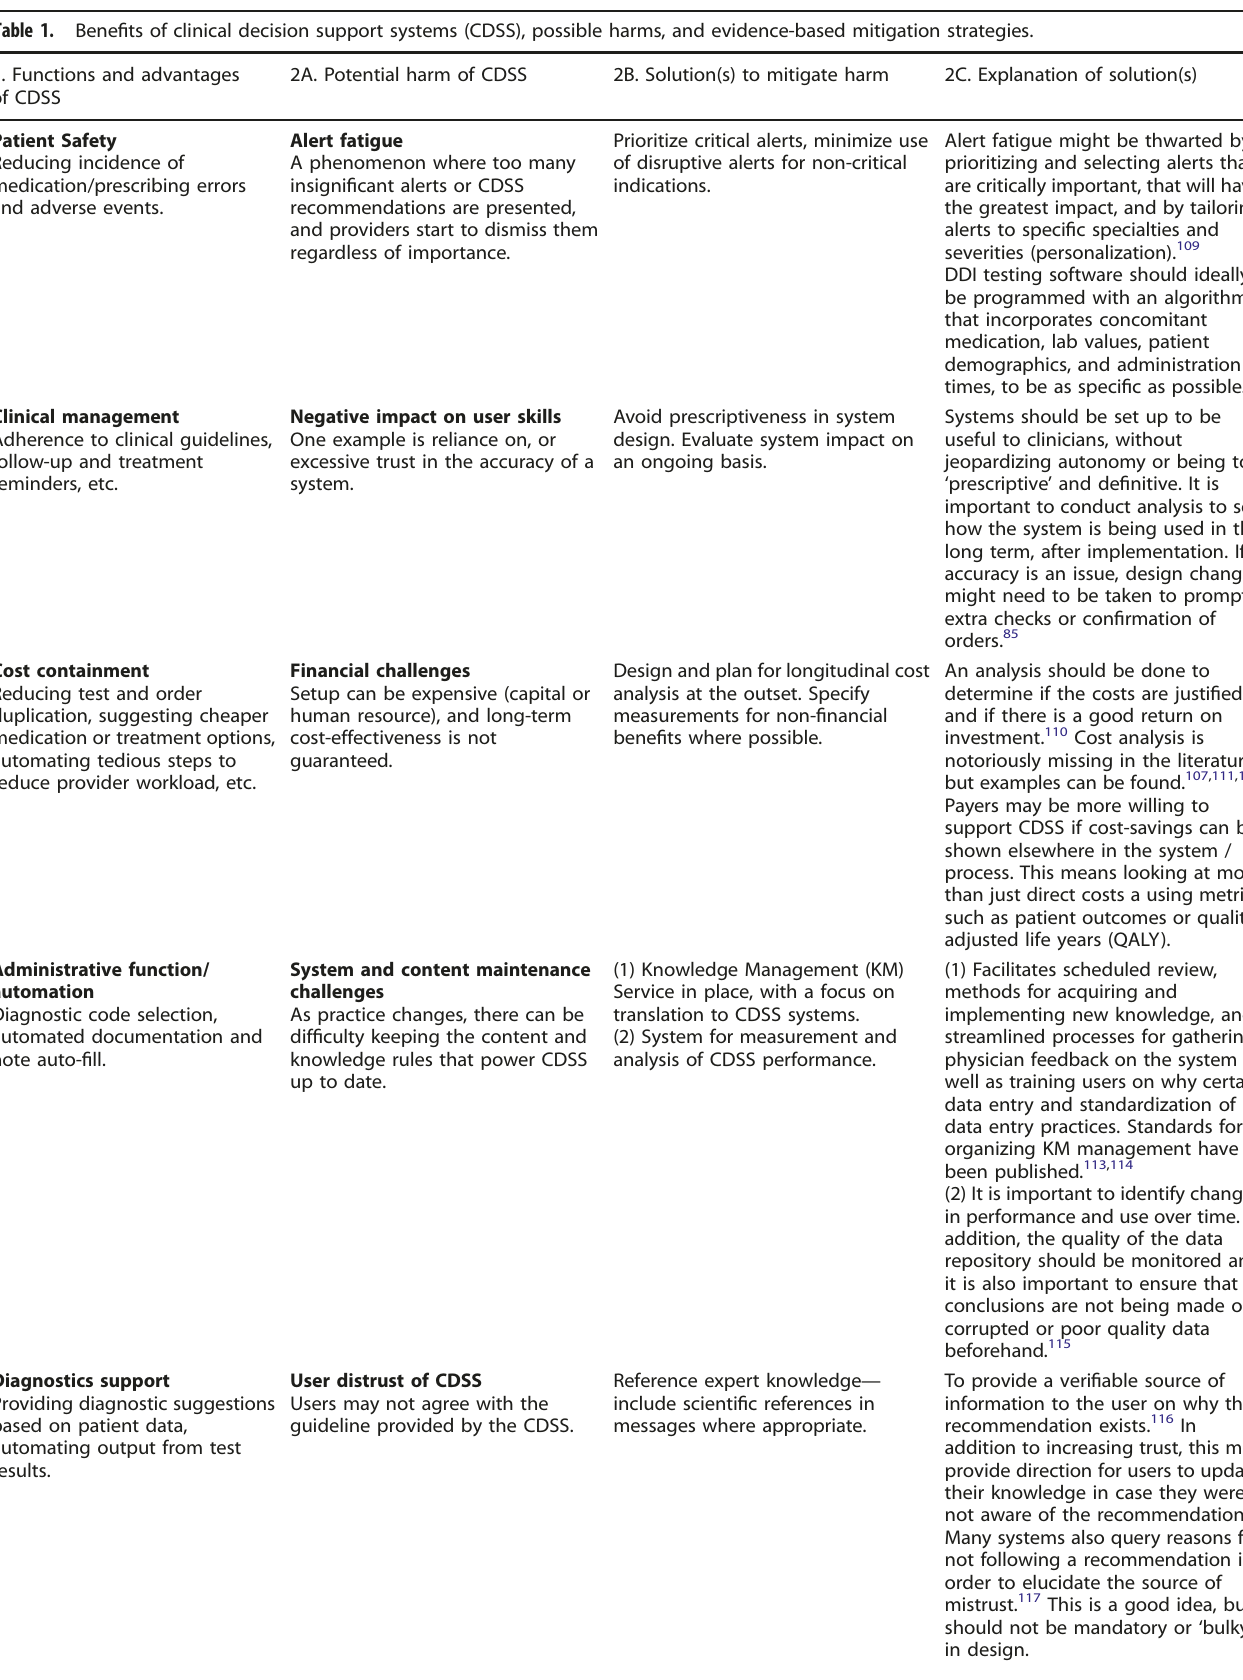
Table 1. Bene fi ts of clinical decision support systems (CDSS), possible harms, and evidence-based mitigation